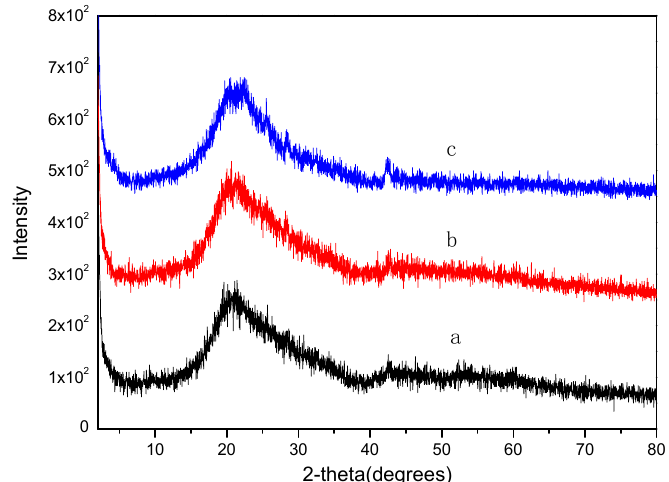
Figure 4. XRD patterns of solid particles: (a) ZPS–PVPA, (b) ZPS–PVPA–SH, and (c) ZPS–PVPA–SO 3 H.